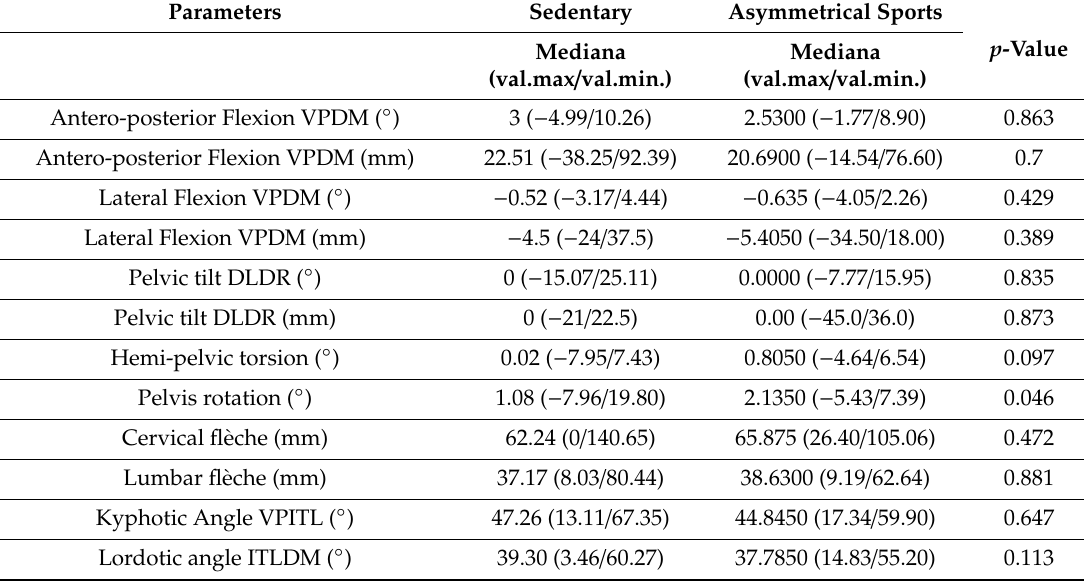
Table 2. Postural comparison between Sedentary and Asymmetrical